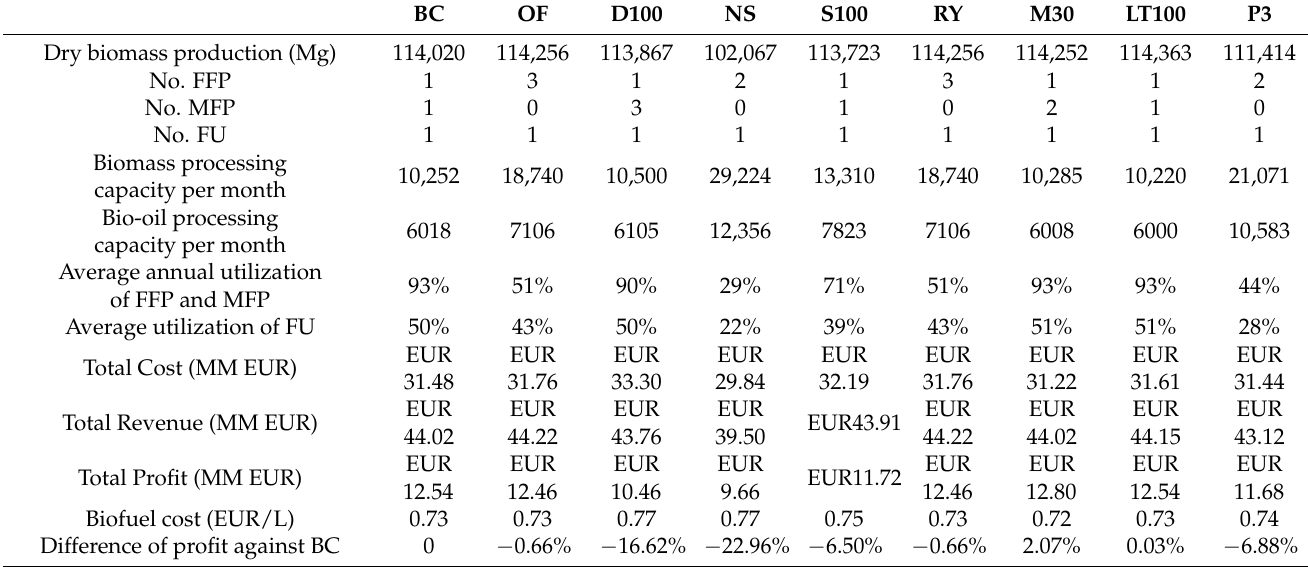
Table 2. Overview of scenario